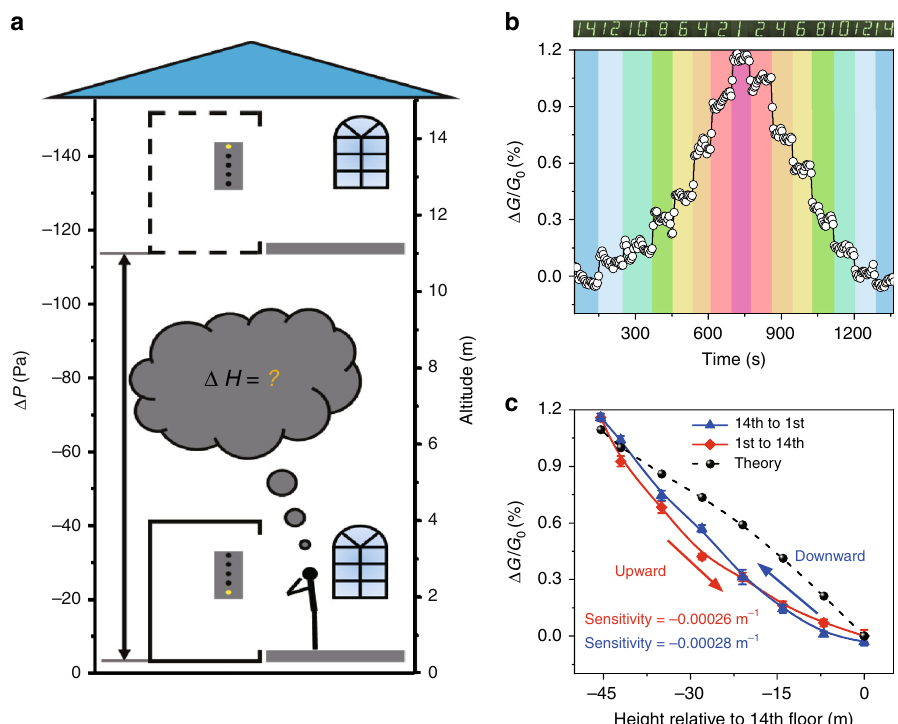
Fig. 4 Altitude measurement with the pressure sensor. a A schematic diagram of differential pressure Δ P to 1 atmosphere as a function of altitude. b Real- time conductance changes in response to the variation in the fl oor elevation. The recorded signal corresponding to each fl oor is indicated by different colored bars. c Measured and calculated Δ G / G 0 versus height curve. Note that G 0 used here is the conductance of the NP arrays measured at 14th fl oor. It corresponds to the conductance of the NP particle array under 500 Pa pressure. Error bars represent the s.d. of conductance. Source data are provided as a Source Data fi